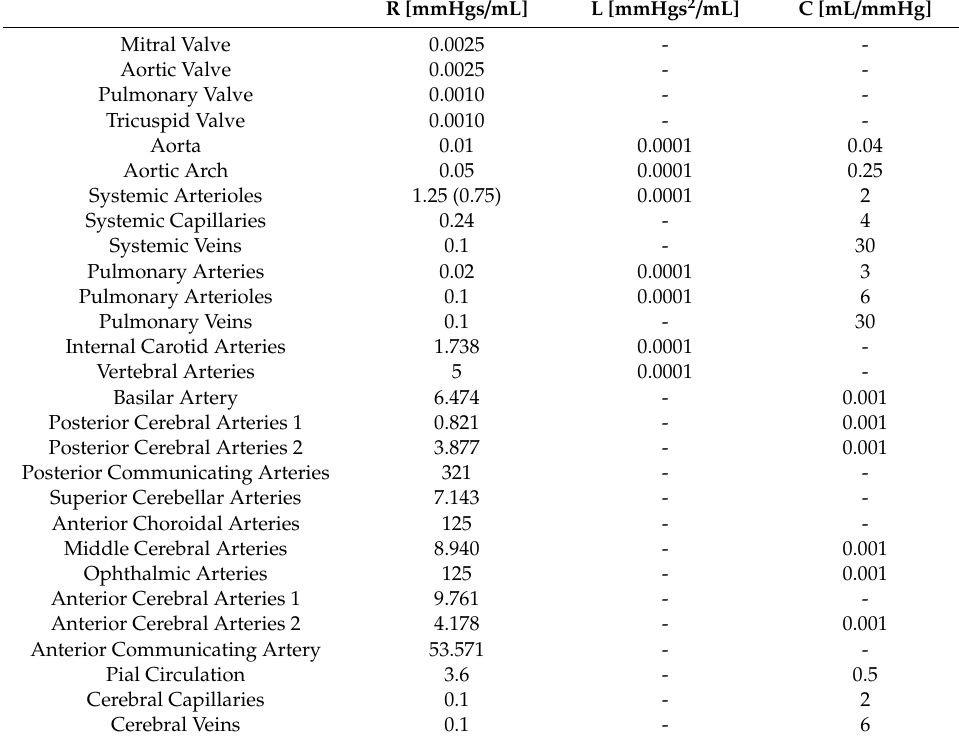
Table A2. Parameter values used circulatory loop. R , L and C represent resistance, inertance and compliance of the blood vessels, respectively. The value in the brackets show systemic arteriolar resistance under CF-LVAD support.